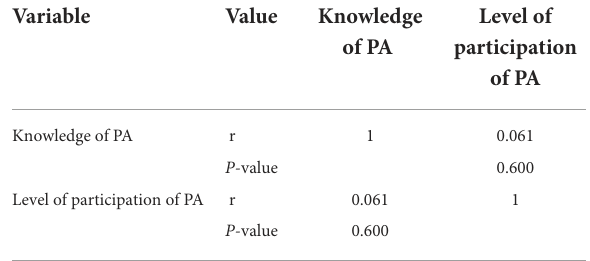
TABLE 4 Participants’ levels of knowledge of physical activity ( n = 77).